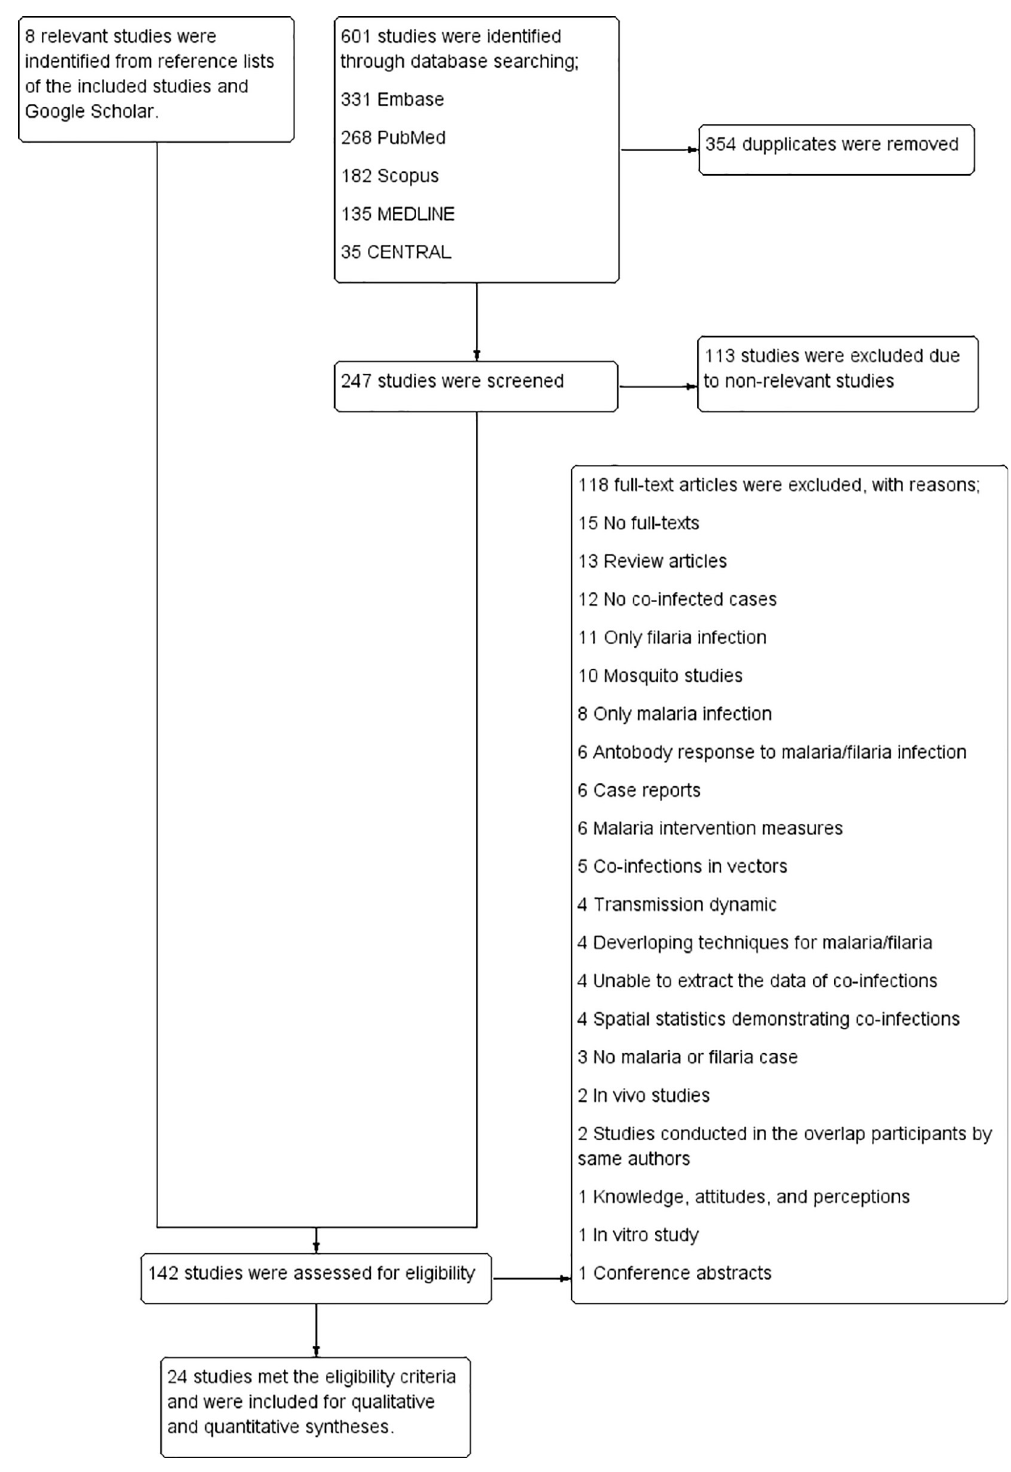
Fig 1. Study flow